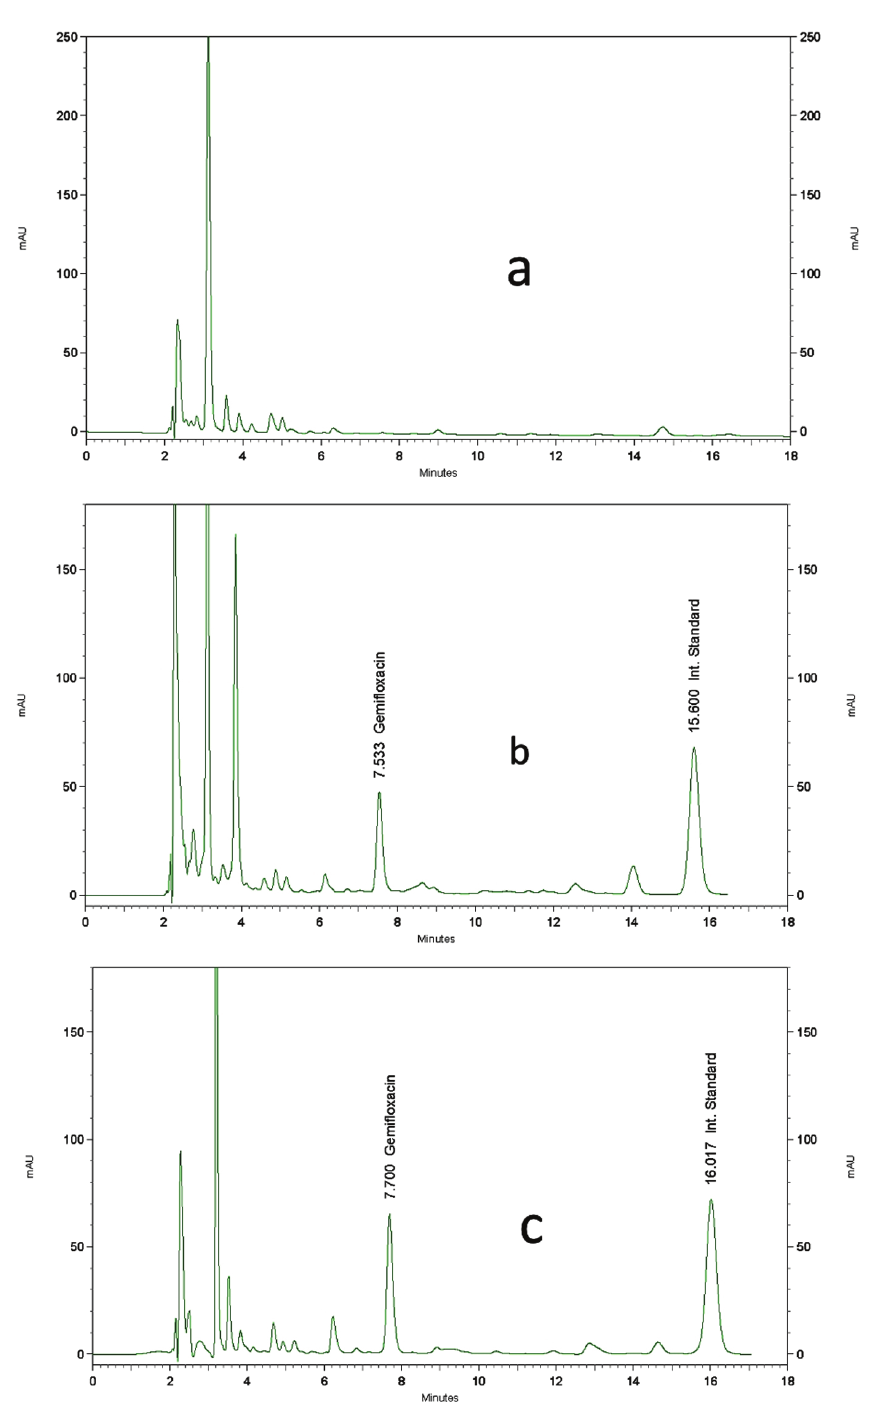
FIGURE 2 - Representative chromatograms of a) blank plasma b) standard chromatogram (0.7 µg mL -1 ) and c) plasma of one volunteer (3